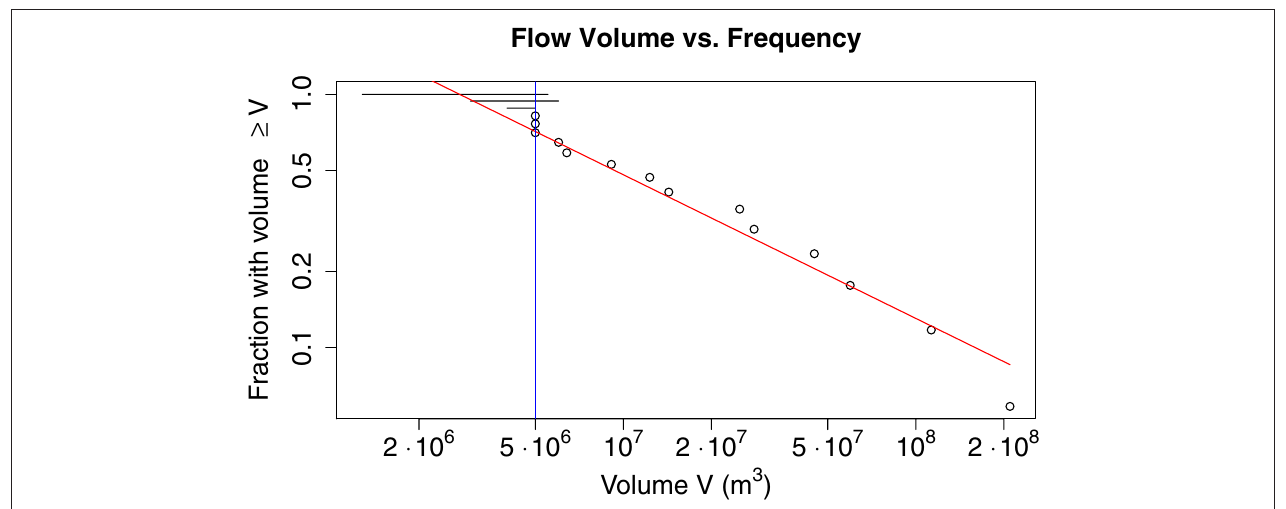
FIGURE 7 | Plot of fraction of PDCs with volume exceeding V , vs. V , on log-log scale, for PDCs of volume V suggests Pareto (power-law) distribution. Measurement artifacts distort entries below about 6 here by horizontal lines, and some small volumes are rounded off, leading to apparent ties in the data.